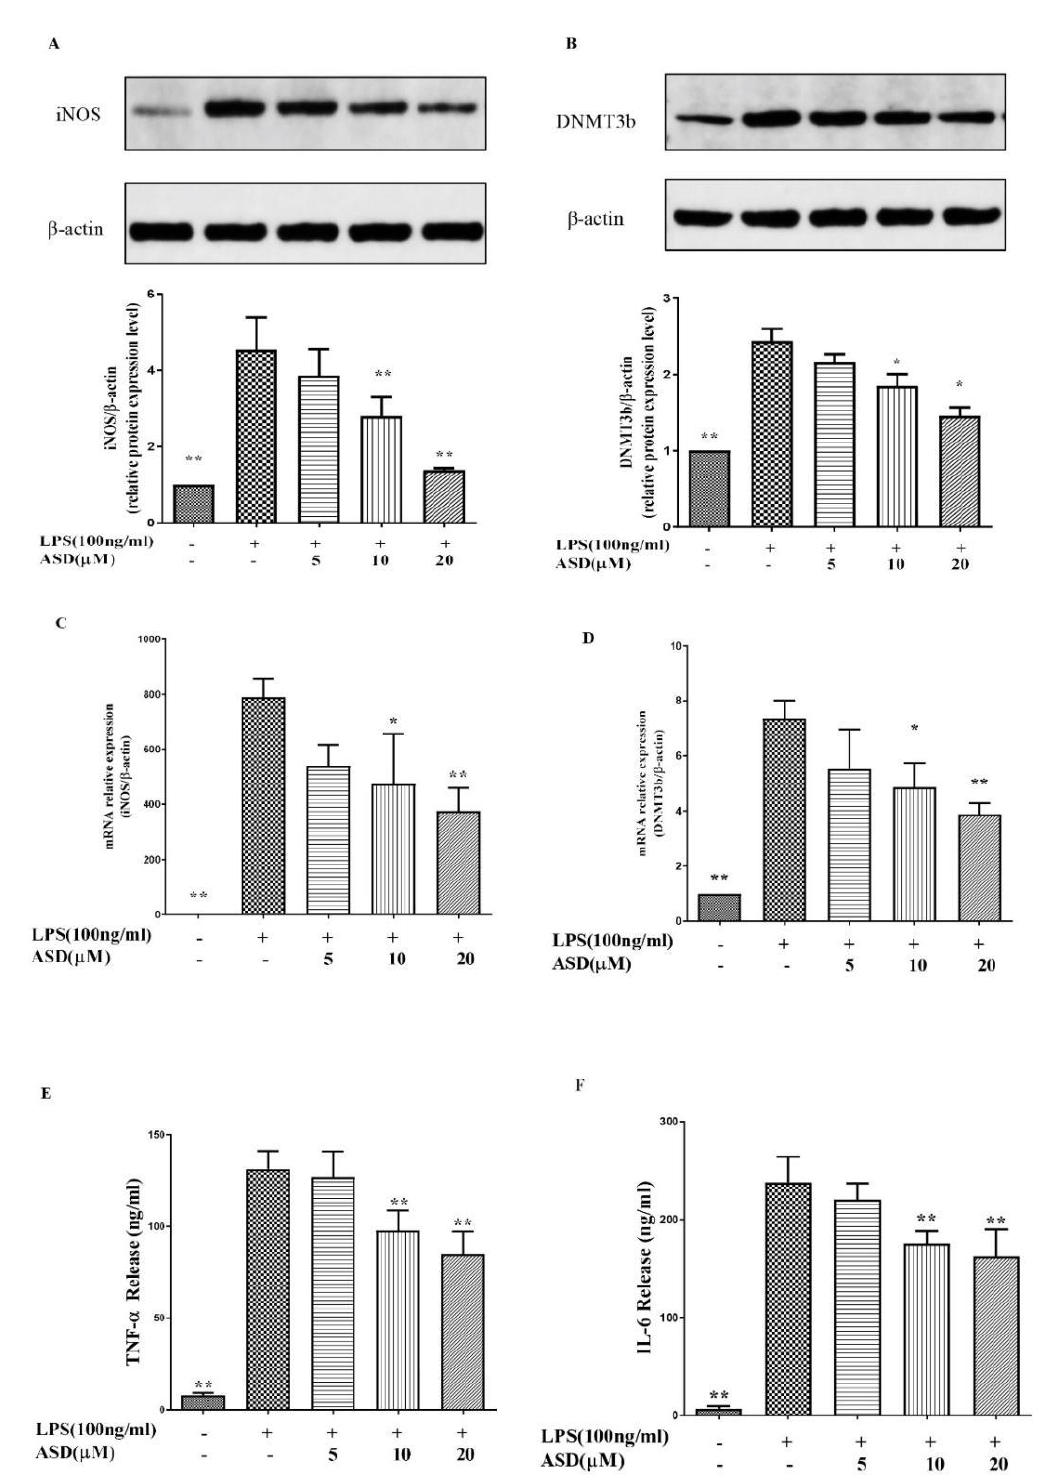
Figure 2. Pharmacological effect of ASD on the levels of iNOS, DNMT3b, TNF- α , and IL-6. The protein expression levels of iNOS ( A ) and DNMT3b ( B ). The gene levels of iNOS ( C ) and DNMT3b ( D ). The protein expression levels of TNF- α ( E ) and IL-6 ( F ). The data are shown as the average value ± SD, * p < 0.05, vs. LPS-treated cells, ** p < 0.01, vs. LPS-treated cells.